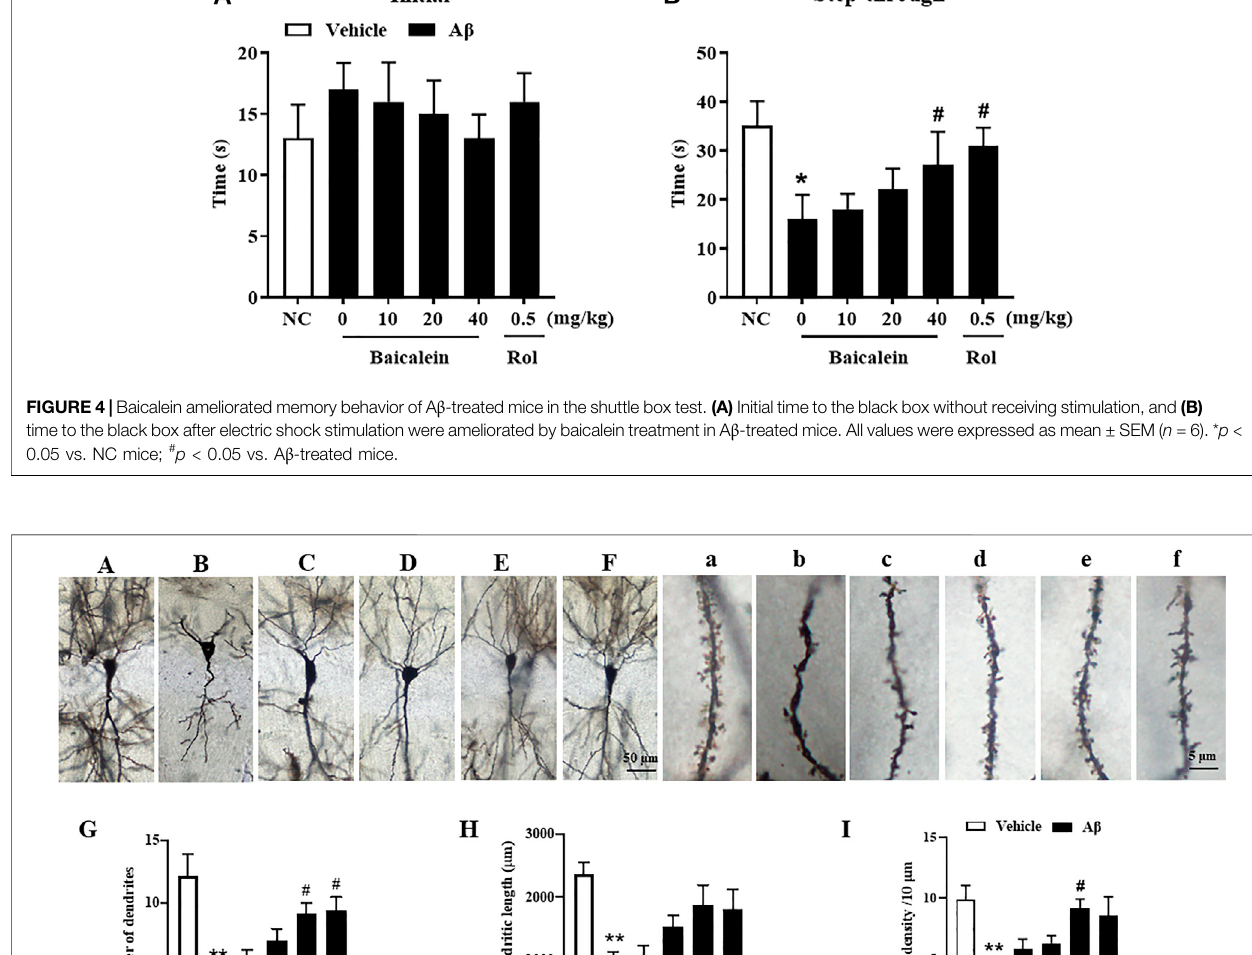
dendrites [ Figure 5G , F (5, 42) (cid:2) 8.19, p < 0.05] and spine density [ Figure 5I , F (5, 42) (cid:2) 7.54, p < 0.05] in a dose-